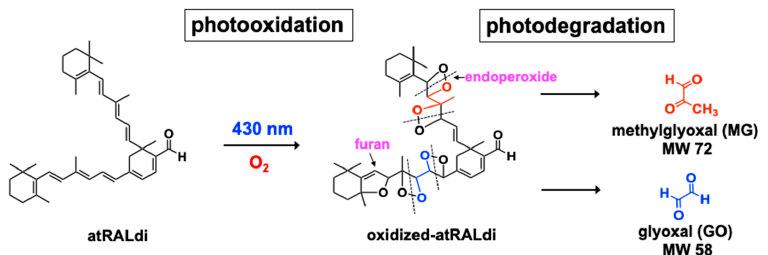
Figure 4. Bisretinoid photo-oxidation followed by photocleavage leads to the release of photodeg- radation products that include the dicarbonyls methylglyoxal (MG) and glyoxal (GO). MW: molec- ular weight. The bisretinoid all- trans -retinal dimer (atRALdi) serves to illustrate. The finding that complements can be activated in serum overlying irradiated, A2E- laden RPE cells is also consistent with the view that reactive cleavage products of A2E are generated by photo-oxidation [65]. These oxidized forms of bisretinoid are detectable in human and murine RPE cells [39], and these bisretinoid-photodegradative processes are responsible for the lower bisretinoid levels measured in albino versus black mice and in light- versus dark-reared mice [66]. Similarly, these processes may be the reason why early and intermediate AMD are associated with lower fundus autofluorescence intensity— measured as quantitative fundus autofluorescence, (qAF)—in the central retina [67]. Methylglyoxal (MG) is known to be generated as a byproduct of metabolic pathways such as glycolysis [57,68]. The release of MG via the photodegradation of bisretinoids reflects a previously unrecognized source.